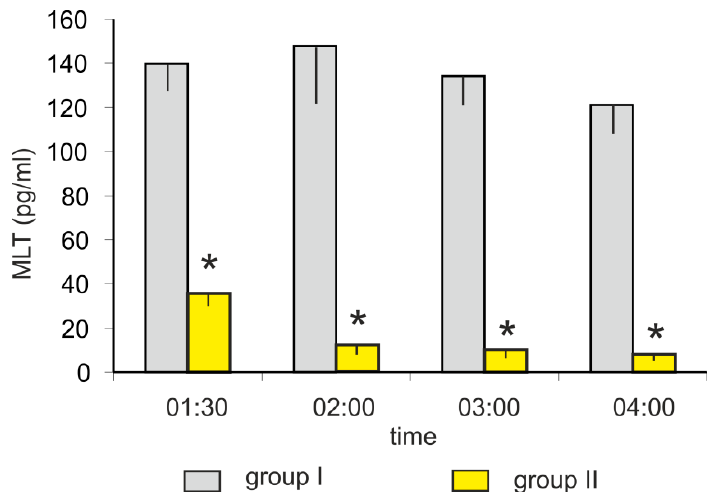
Figure 2. Experiment II. Concentration (mean and SEM) of melatonin in blood plasma in control (group I) and light-exposed (group II) turkeys at 01:30, 02:00. 03:00, and 04:00 h. The exposition of birds from group II started at 01:00 h. Values flagged with “*” differed significantly from the corresponding controls.